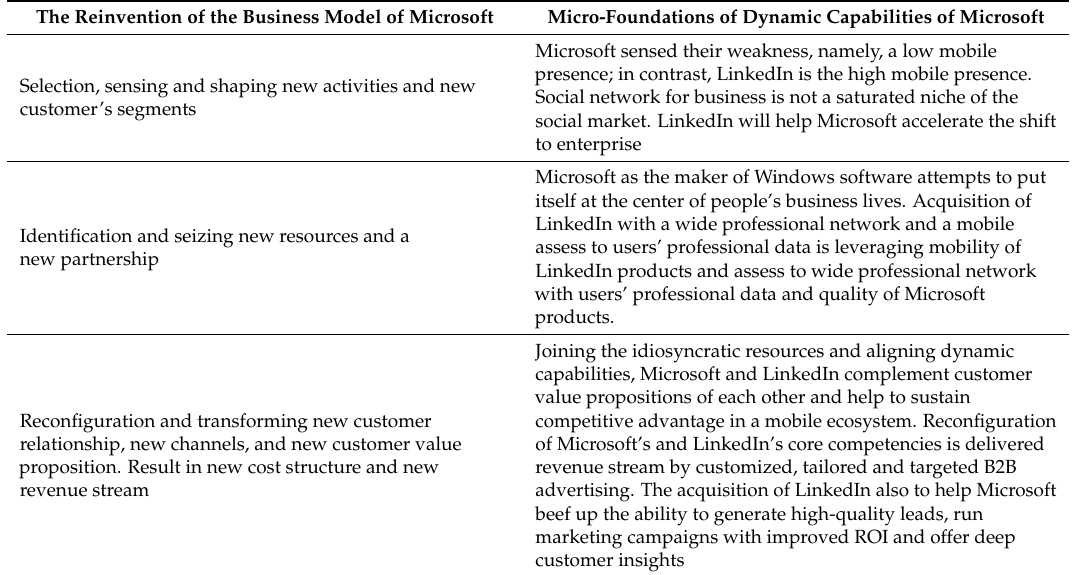
Table 8. Bridging perspectives together: the reinvention of Microsoft business model (BM) acquiring LinkedIn and micro-foundations of dynamic capabilities underpinning a transformation of BM building